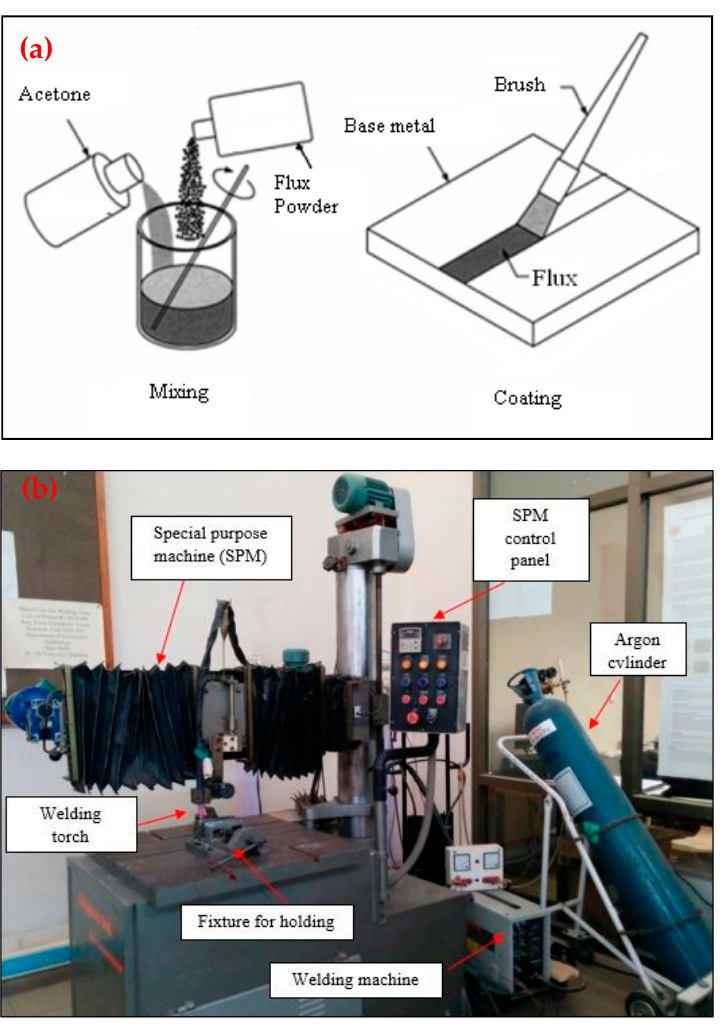
Figure 1. Schematic setup showing ( a ) preparation and application of activating flux, ( b ) in-house A-TIG welding setup.